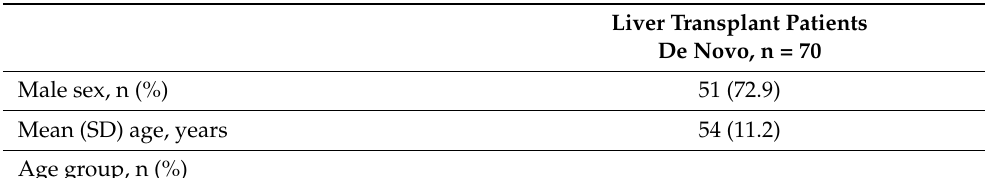
Figure 1. Patient disposition. [a] Switch from other tacrolimus (n = 14), unknown immunosuppressant (n = 2), or LCPT pretreatment (n = 2); no switch from prior cyclosporine. [b] As per the study protocol, eight visits over 180 ± 7 days were planned; however, only four visits were compulsory, and six patients were lost to follow-up. Table 1. Patient demographics and disease characteristics of de novo LCPT liver transplant patients at